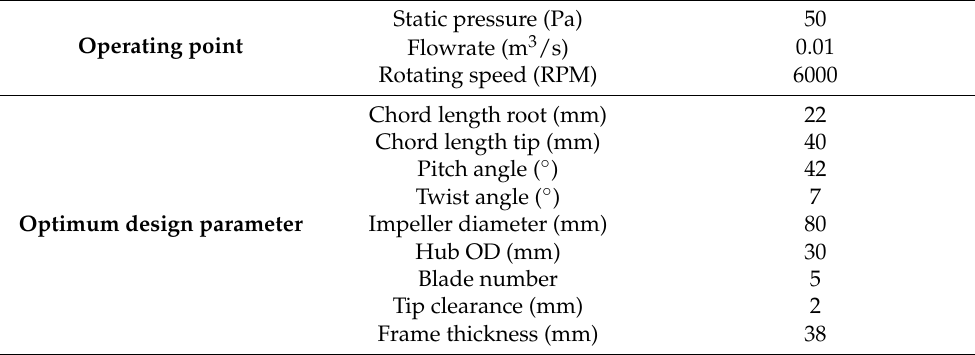
Table 8. Operating point, optimum design parameter, and assessment